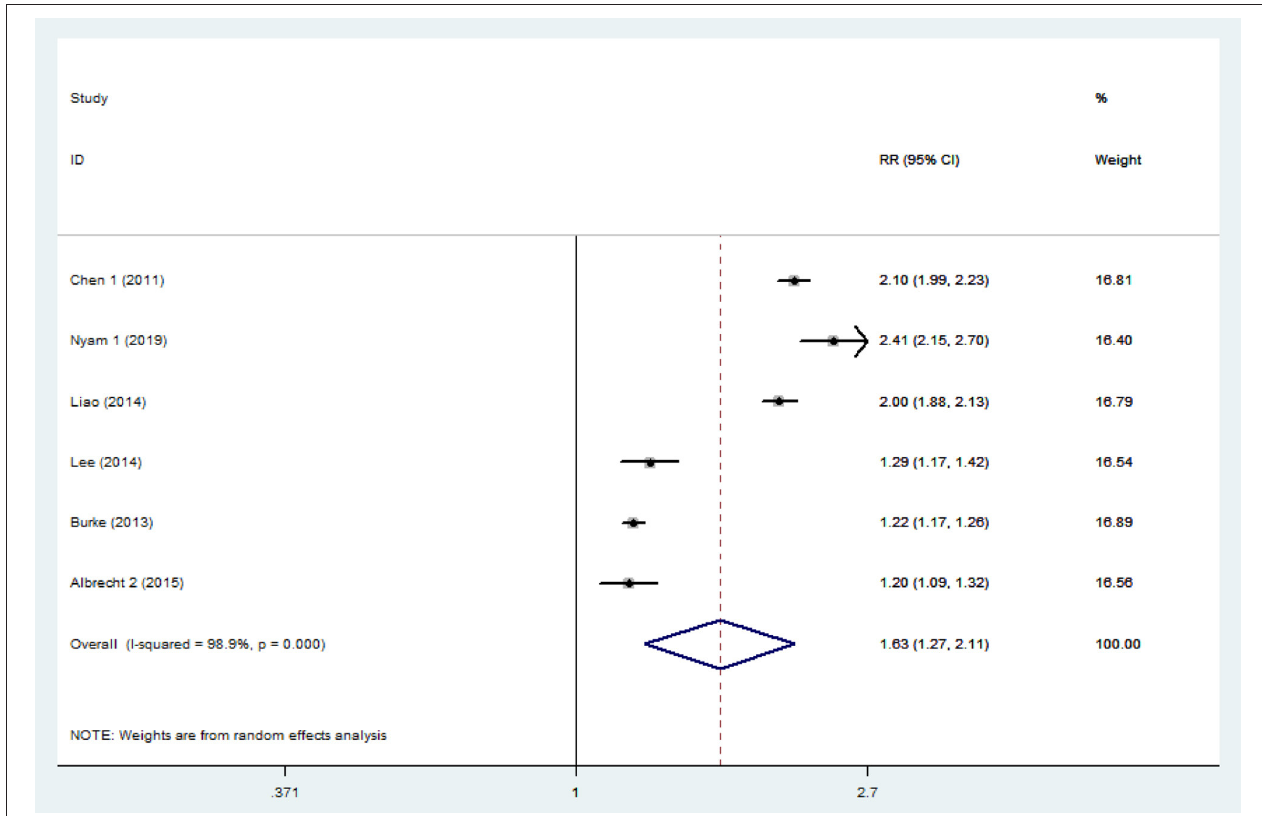
FIGURE 2 | Forest plots of the association between traumatic brain injury and future stroke in all included studies. The meta-analysis was performed using a random-effects model. The overall analysis is shown. Diamonds represent the pooled estimates, and the horizontal lines represent the 95% confidence intervals. RR, relative risk; CI, confidence